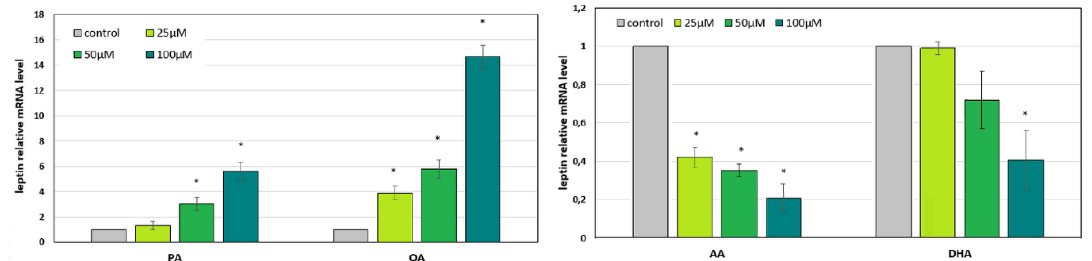
Figure 2. The relative mRNA level of leptin in 3T3-L1 adipocytes cultured for 48 h with various concentrations of palmitic acid 16:0 (PA), oleic acid 18:0 (OA), arachidonic acid 20:4 n-6 (AA), and docosahexaenoic acid 22:6 n-3 (DHA) or without FA supplementation (control). * Significantly different compared to the control ( p < 0.05). Data are presented as the mean ± SD. All experiments were run in three independent attempts.